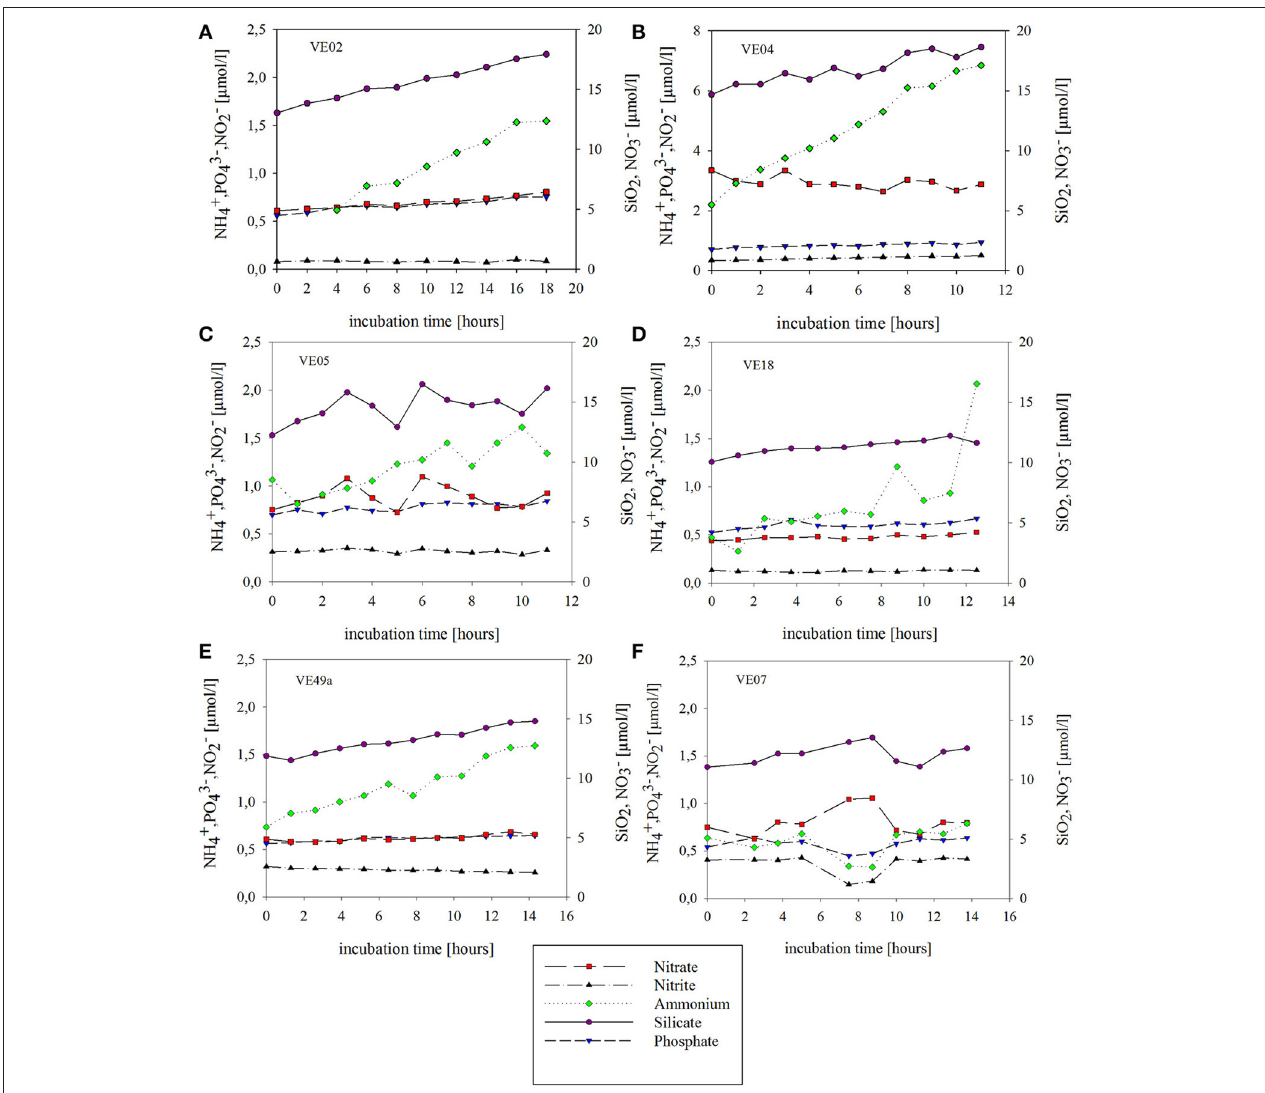
FIGURE 5 | Concentration changes over time during the chamber lander incubations of sediment and bottom water at five sandy coastal stations (A–E) and one muddy intermediate station (F) . Symbols indicate the time points at which the water samples were taken (via syringes) and the concentration of each nutrient at each time point. The lines connecting the time points show the tendency of the concentration development. SiO 2 is indicated in purple, NH + 4 in green, NO − 3 in red, NO − 2 in black, and PO 3 − 4 in